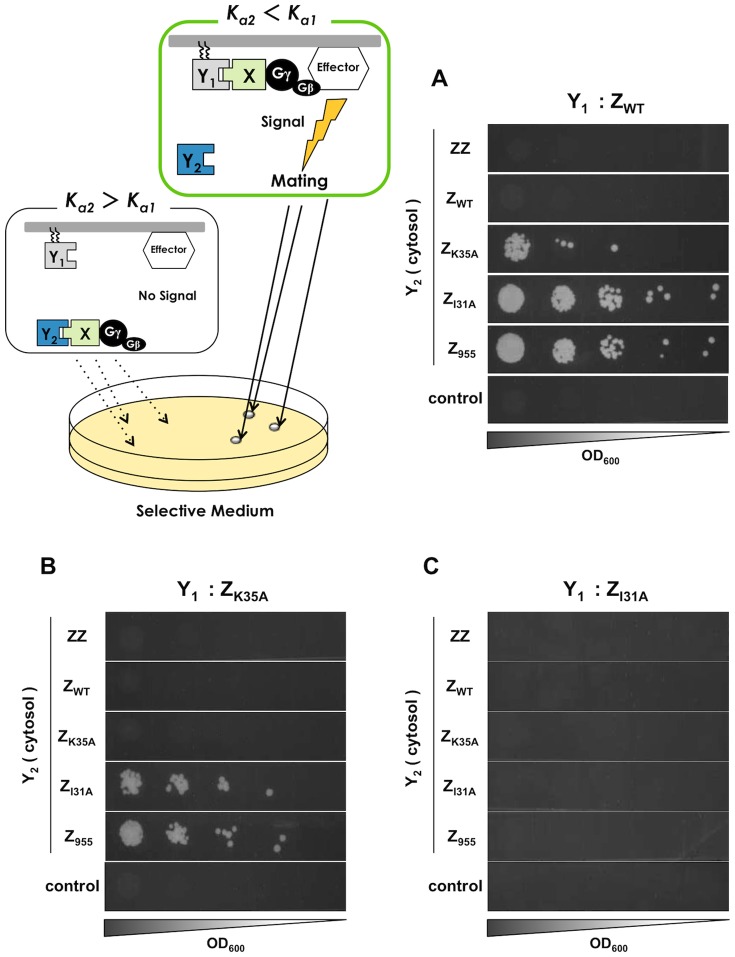
Mating growth selection to test the screening of affinity-attenuated proteins.The signal-promoted cells were isolated following formation of methionine- and lysine-prototrophic diploids. Growth of the engineered strains expressing membrane-anchored ZWT (A), ZK35A (B) and ZI31A (C) as the parental ‘Y1’ proteins. Five Z variants (ZZ, ZWT, ZK35A, ZI31A and Z955) were expressed as the cytosolic ‘Y2’ candidate proteins in each strain. Control indicates the yeast strain lacking expression of ‘Y1’ and ‘Y2’ (transformed with pGK415 mock vector to BFG2118). BY4742 was used as the mating partner.